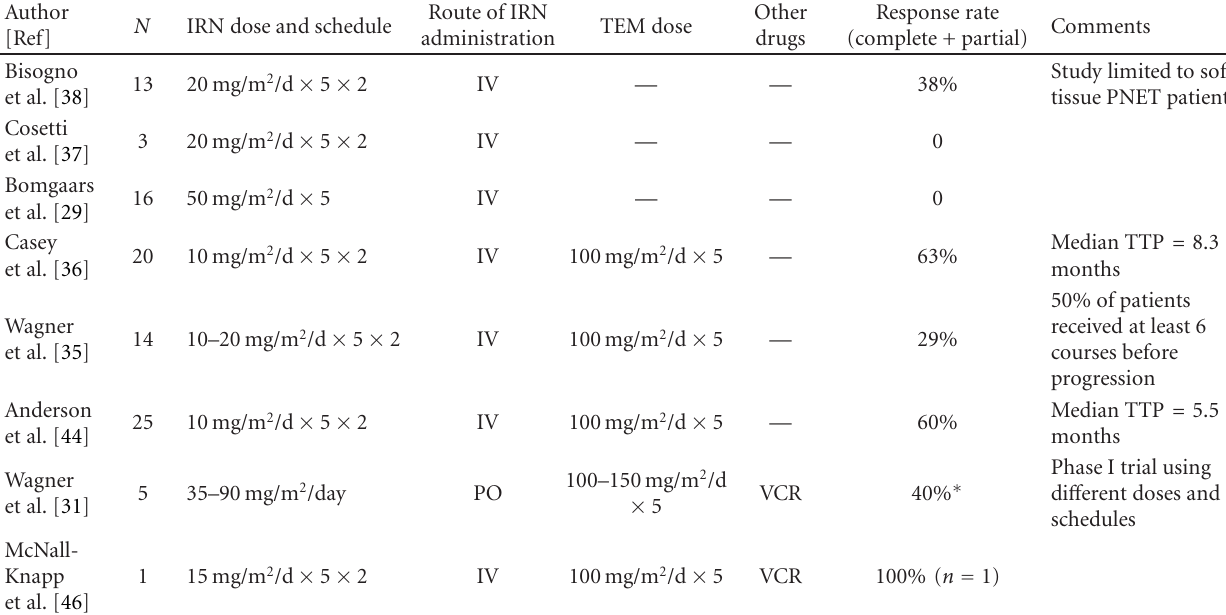
Table 2: Summary of studies using irinotecan-based therapy for patients with relapsed/refractory Ewing sarcoma.